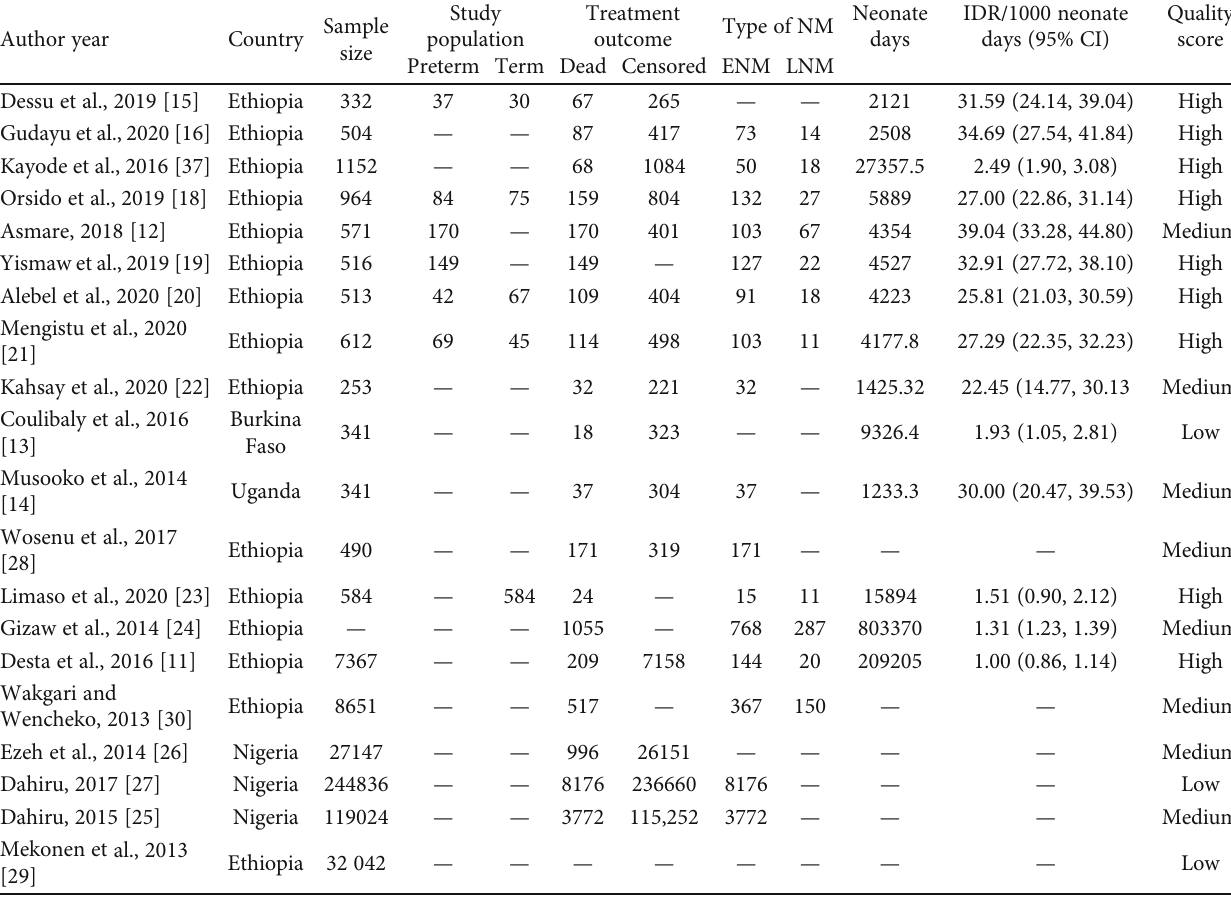
Figure 1: PRISMA fl ow chart showing the literature search Table 1: Incidence density rates (IDRs) of neonatal mortality in Sub-Saharan Africa.